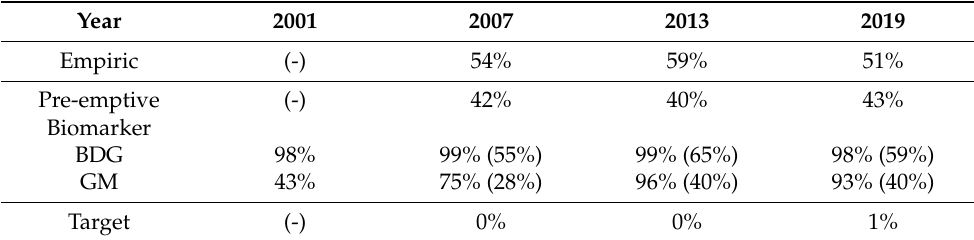
Table 1. Treatment strategy of the invasive fungal infection in